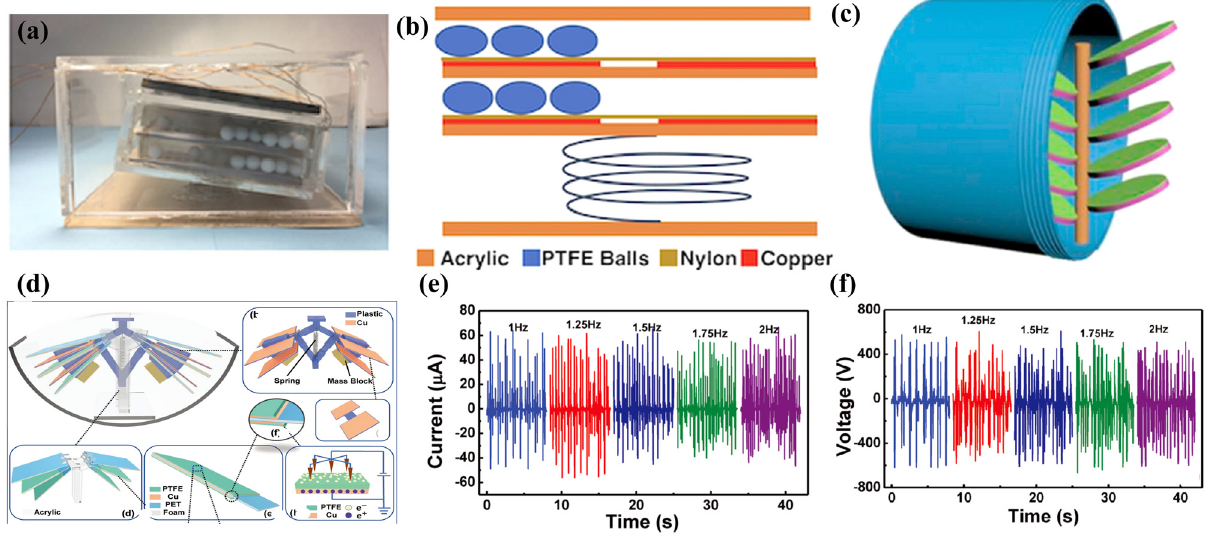
Figure 8: ( a and b ) SS - TENG structure picture [ 72 ] , ( c ) BITENG structure diagram [ 73 ] , ( d ) B - TENG structure diagram, and ( e and f ) B - TENG response diagram of output current and voltage at di ff erent frequencies [ 74 ]